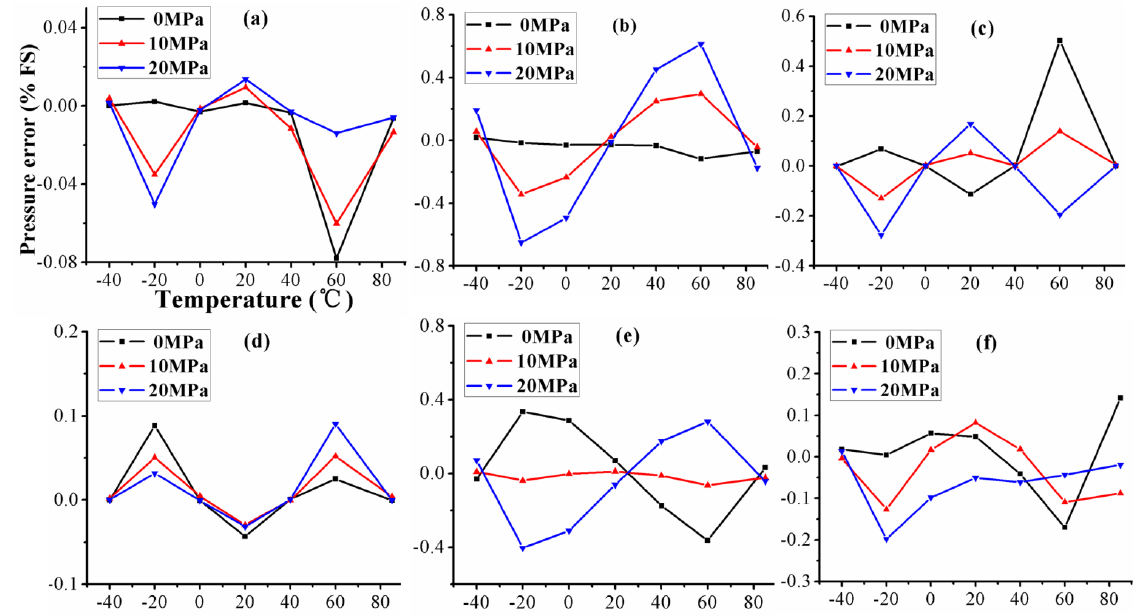
Figure 10. The compensated errors of algorithms at three pressure points on temperature